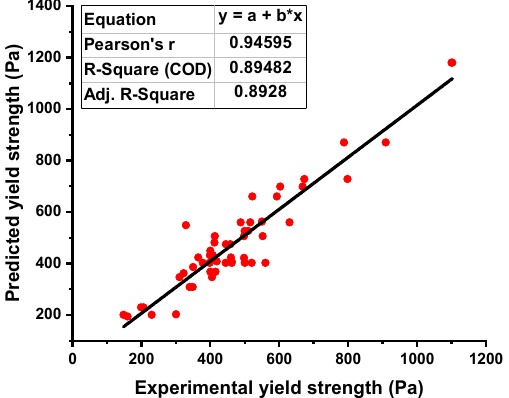
Figure 3. Yield stress relationship for the actual and predicted result of ANN model.